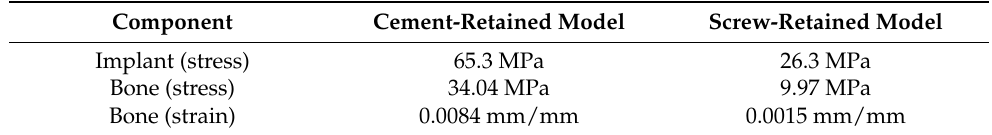
Table 3. Maximum von Mises stress and strain values in the implant and surrounding bone under 100 N vertical load in the finite element model.